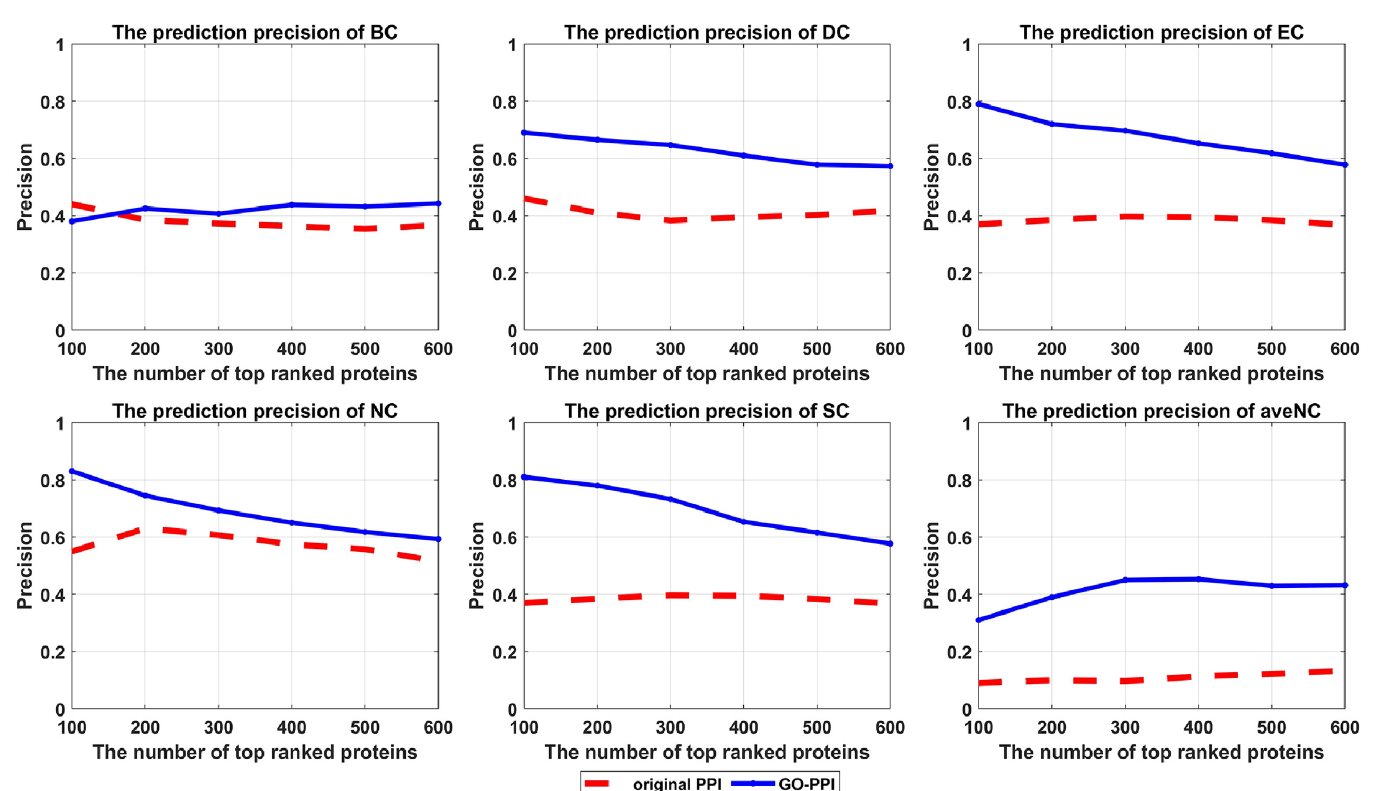
Fig 3. Prediction precision of six centrality methods under the original PPI network and reconstructed GO-PPI network for the YDIP dataset.